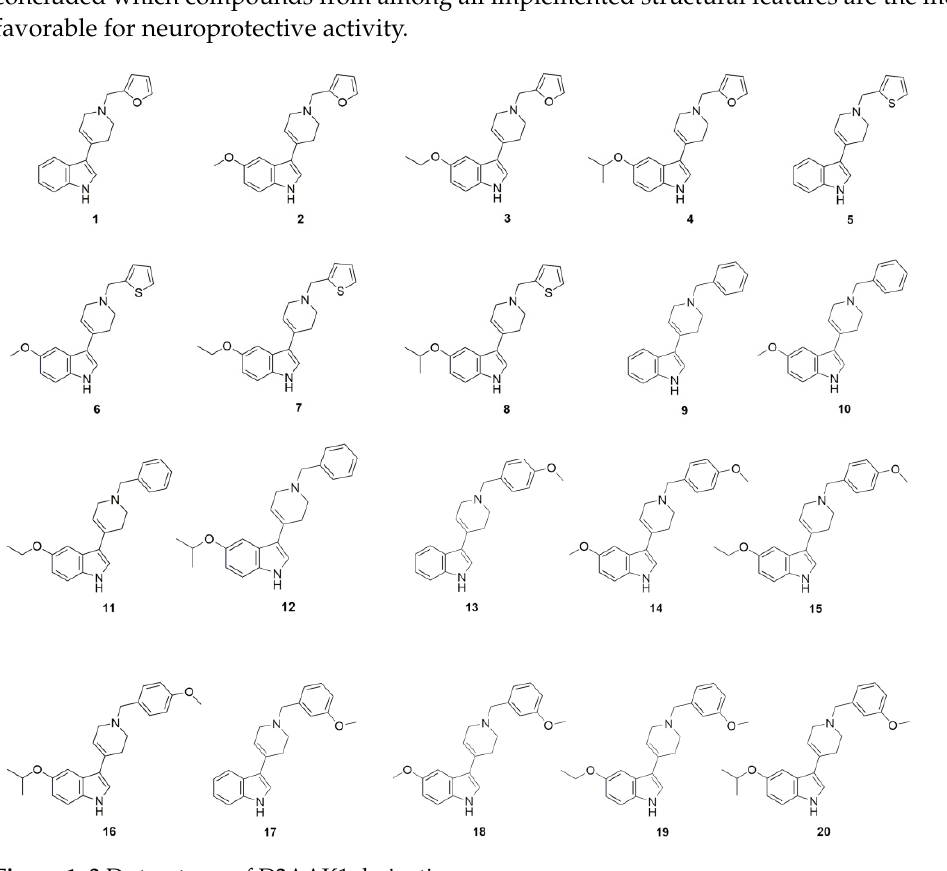
Figure 1. 2 D structures of D2AAK1